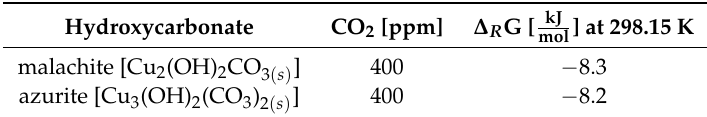
Table 1. Gibbs free energy of the malachite and azurite reaction (Equations (3) and (4)) at 298.15 K at 400 ppm of CO 2